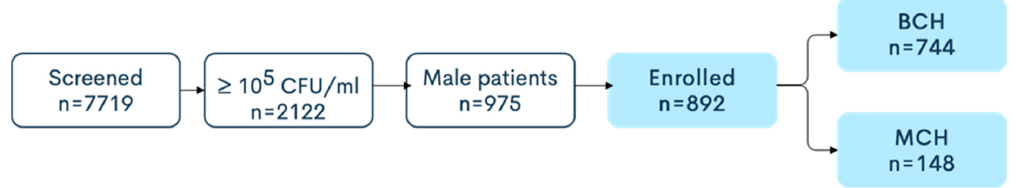
Figure 1. Screening eligibility and enrolment of the study population.